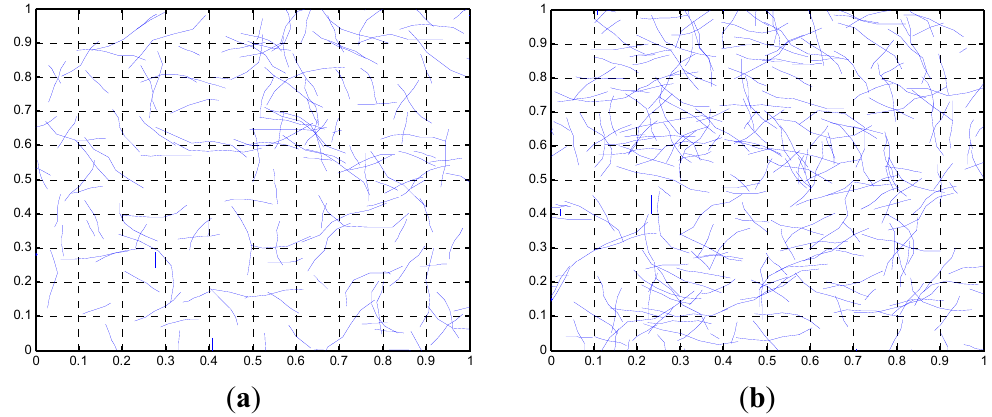
Figure 4. Network of fibers with lengths following a Weibull distribution ( a ) c = 0.01 and ( b ) c = 0.02.